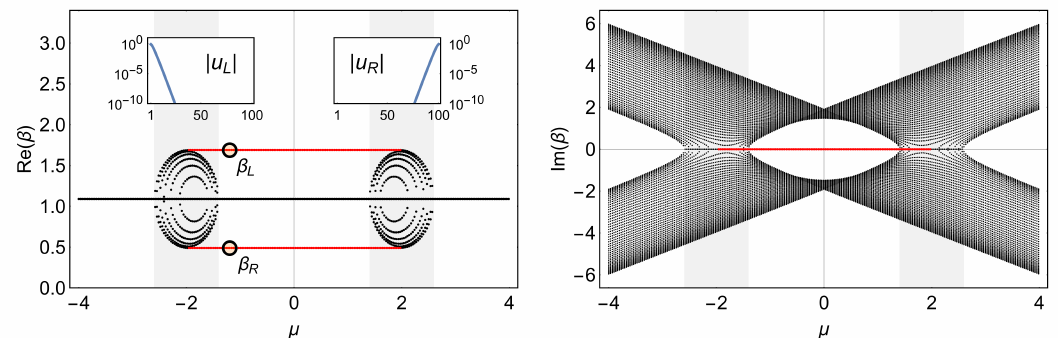
Figure 2: The real (left) and imaginary (right) parts of the spectrum of X with OBC, as a function of the chemical potential µ . The localized edge modes with rapidity β = g ( 1 ± ∆ ) 2 are highlighted in red. In the shaded regions, the AUS is broken and the bulk band gap is closed. The insets show on a semi-log scale the localization of the eigenvectors u and u , corresponding to the marked rapidities β L R µ = − 1.2. The other parameters are: N = 50, J = 1.0, γ = 0.8, g = 1.0, ∆ =